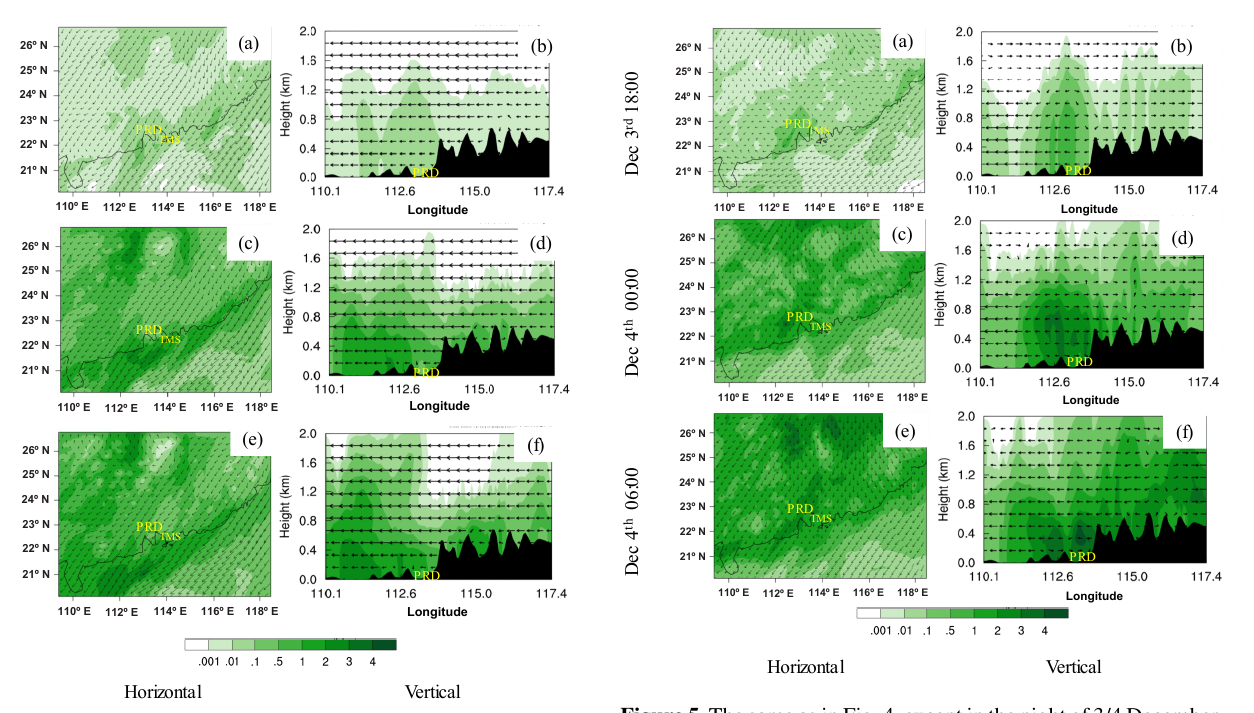
Figure 4. Horizontal distributions of ClNO 2 concentrations (ppb) at (a) 18:00LT on 1 December, (c) 00:00LT on 2 December and (e) 06:00LT on 2 December within the PBL from the HET + Cl case; vertical distributions of ClNO 2 concentrations (ppb) at (b) 18:00LT on 1 December, (d) 00:00LT on 2 December and (f) 06:00LT on 2 December in the domain intercepting PRD and along the prevailing wind direction from the HET + Cl case.